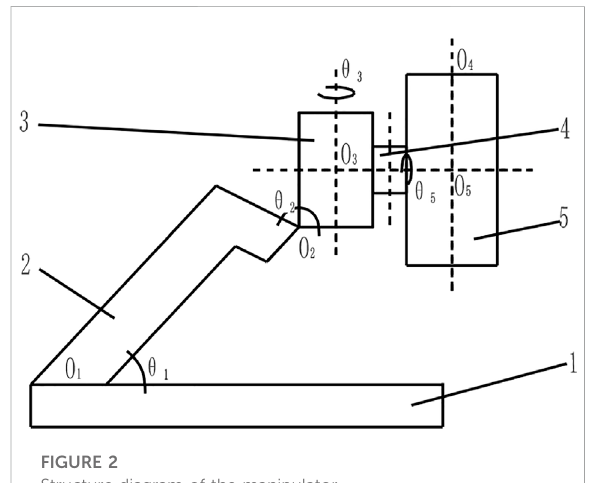
FIGURE 2 Structure diagram of the manipulator.